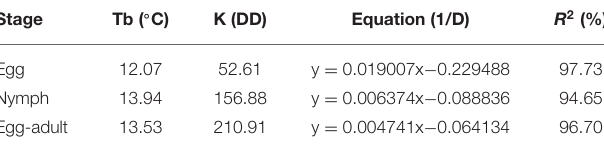
TABLE 4 | Lower threshold temperature (Tb, ◦ C), thermal constant (K, degree-days), development rate (1/D), and determination coefficient ( R 2 ) of